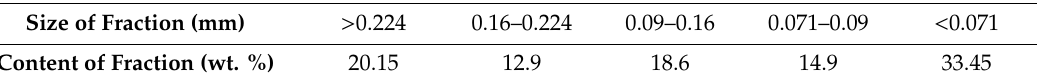
Table 1. Granulometric composition of the flotation tailings of apatite-nepheline dressing plant ANDP-2 [1].